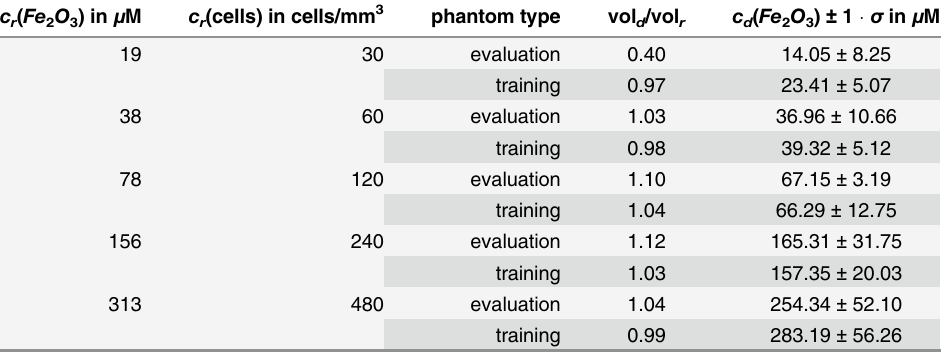
Table 1. Comparison of the the calculated iron oxide concentrations and volumes for the training and evaluation phantoms. O μ M c r (cells) in cells/mm 3 phantom type vol d /vol r c d ( Fe O ± 1 (cid:4) σ in μ M c r ( Fe 2 3 ) in 2 3 ) 19 30 evaluation 0.40 14.05 ± 8.25 training 0.97 23.41 ± 5.07 38 60 evaluation 1.03 36.96 ± 10.66 training 0.98 39.32 ± 5.12 78 120 evaluation 1.10 67.15 ± 3.19 training 1.04 66.29 ± 12.75 156 240 evaluation 1.12 165.31 ± 31.75 training 1.03 157.35 ± 20.03 313 480 evaluation 1.04 254.34 ± 52.10 training 0.99 283.19 ± 56.26 Comparison of the detected iron oxide volumes (vol d ) and concentrations (c d ) with the real volumes (v r ) and concentrations (c r ) used during phantom fabrication. The comparison was carried out on the training phantom of the SVM and an evaluation phantom.